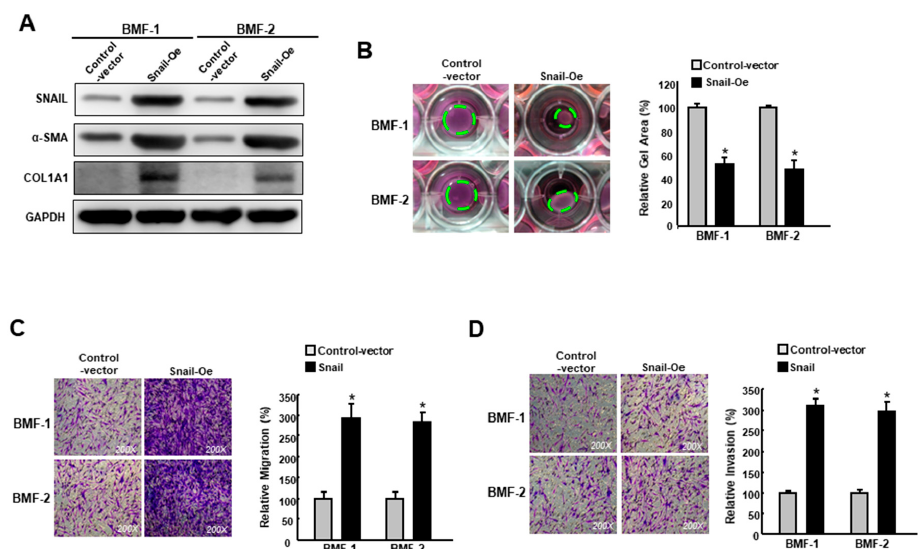
Figure 4. Overexpression of Snail enhances the features of myofibroblasts. ( A ) The protein expression level of Snail, α -SMA and type I collagen in BMFs overexpressing Snail or control vector; ( B ) Collagen gel contraction, ( C ) migration and ( D ) invasion capacities in BMFs overexpressing Snail or control vector. The area of the gel is indicated by the green dotted line. Results are means ± SD of triplicate samples from three experiments. * p < 0.05 compared to control vector.